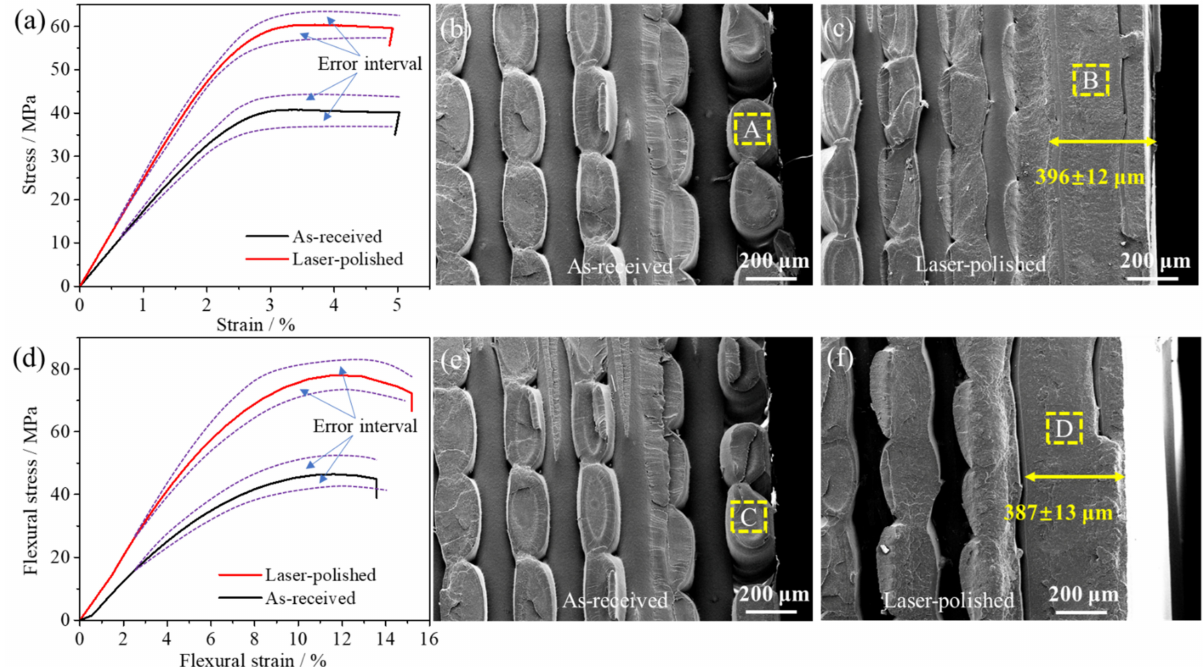
Figure 6. Tensile and flexural tests: ( a ) tensile stress–strain curves; ( b ) tensile SEM fracture of as-received specimen; ( c ) tensile SEM fracture of laser-polished specimen; ( d ) flexural stress–strain curves; ( e ) flexural SEM fracture of as-received Figure 7. Flexural properties and standard deviation; ( f ) flexural SEM fracture of Laser-polished. (A, B, C, D will be enlarged in Figure 7).